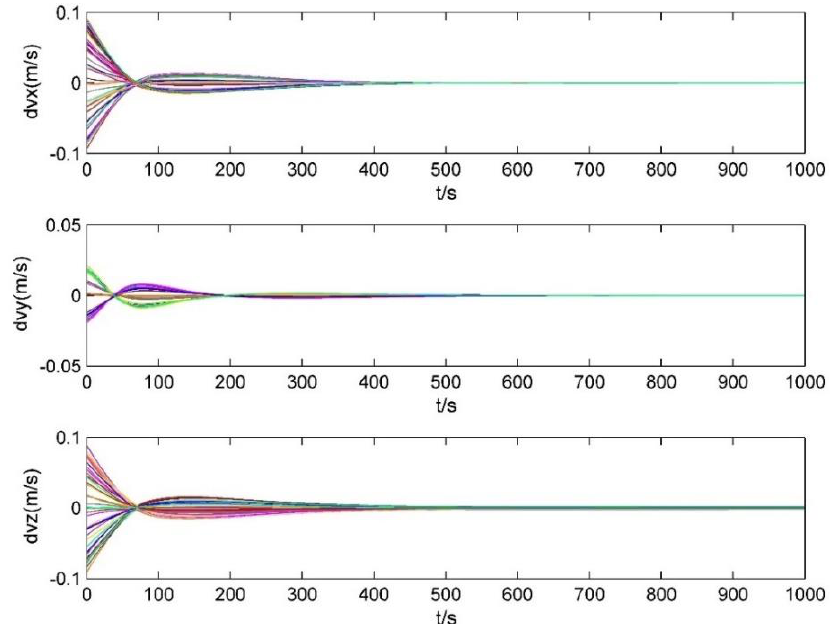
Figure 13. The three-axis velocity increments of each satellite during formation control (in-plane circle formation, µ = − 5 km).